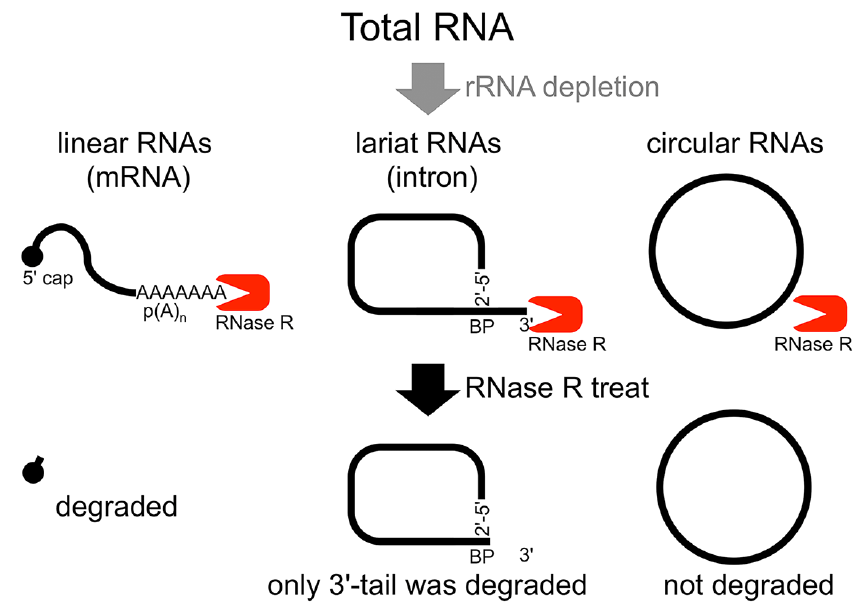
Figure 1. Flow chart of RNase R treatment. Linear RNAs such as mRNAs can be degraded by RNase R treatment. RNase R can also degrade the 3' tail region of an intron lariat RNA. Conversely, the circular part of the lariat RNA and circular RNAs are resistant to RNase R treatment. When total RNA is used as an RNA source, rRNA (major linear RNAs in the total RNA) depletion can help to enrich circular